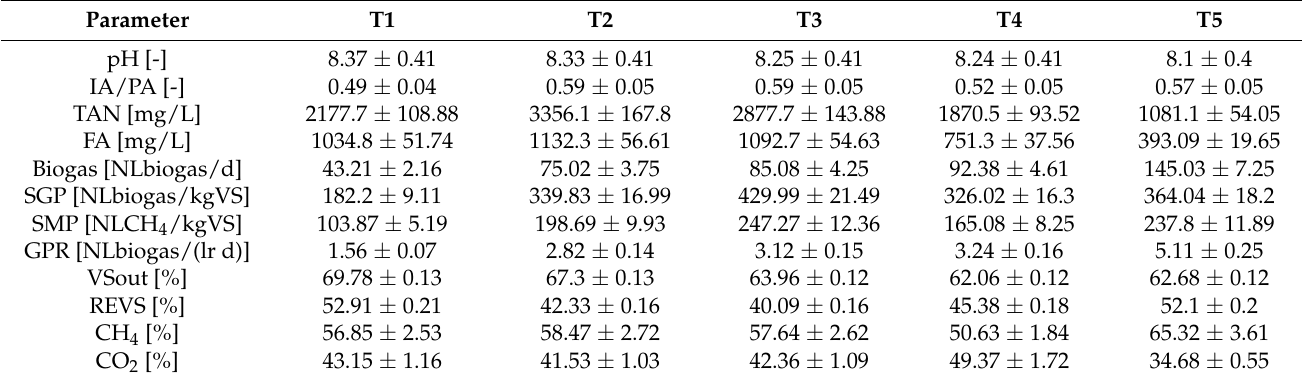
Table 2. Process performance in each digestate sampling